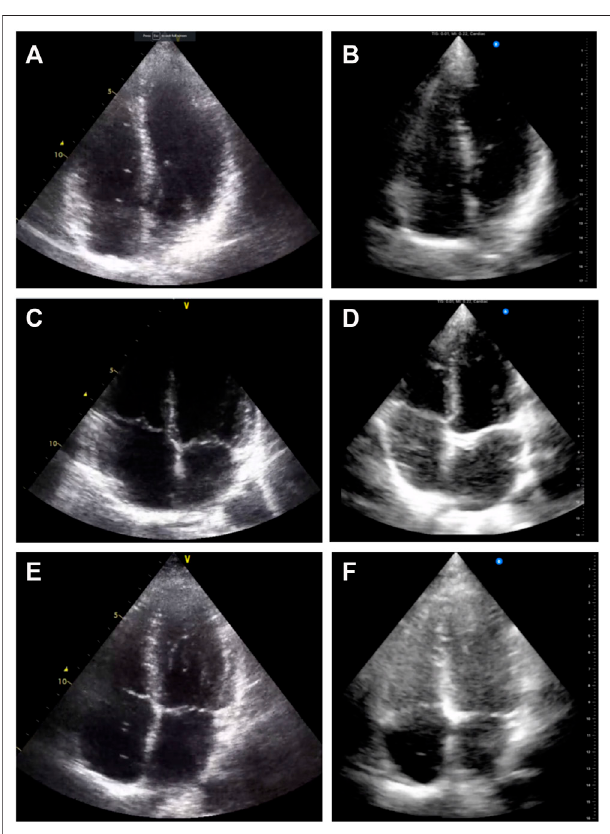
FIGURE 3 | Example echocardiography images acquired with the Vivid q ™ (A) , (C) , and (E) and with the Butter fl y iQ ™ (B) , (D) , and (F) . Three different volunteers at the same measurement time point are presented for comparison (A – B) , (C – D) , and (E – F)